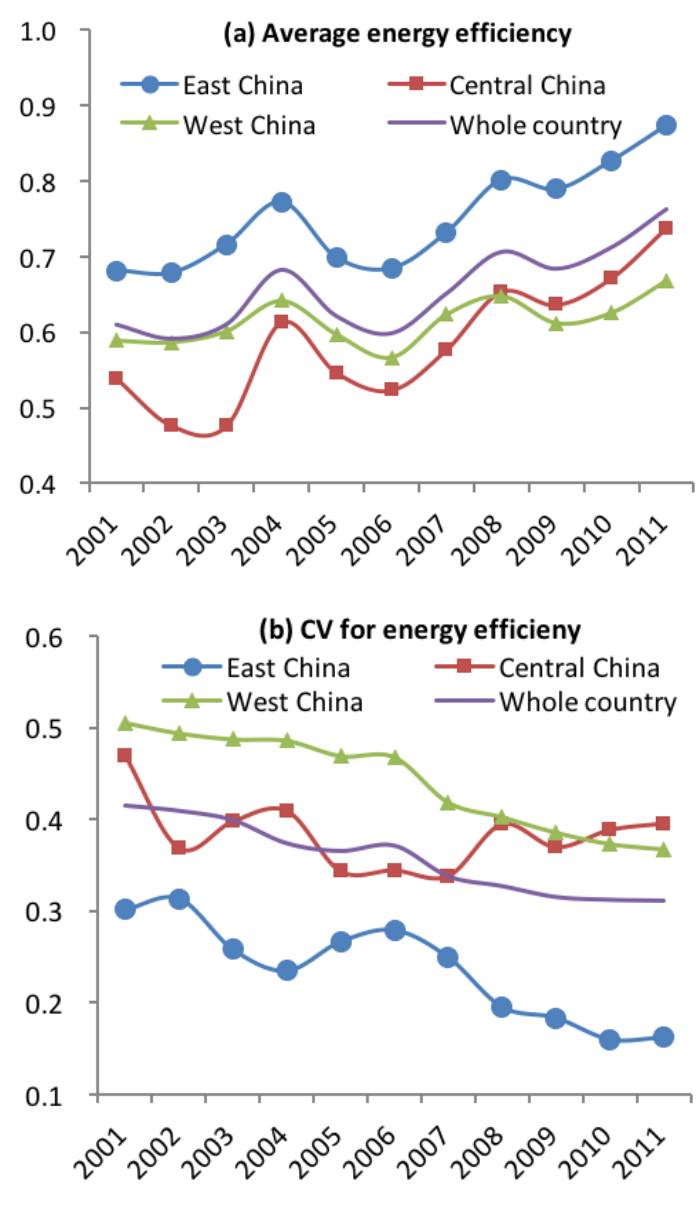
Figure 1. Energy efficiency and differences in the agricultural sector by regions and year (2001–2011). ( a ) Average energy efficiency; ( b ) coefficient of variation(CV) for energy